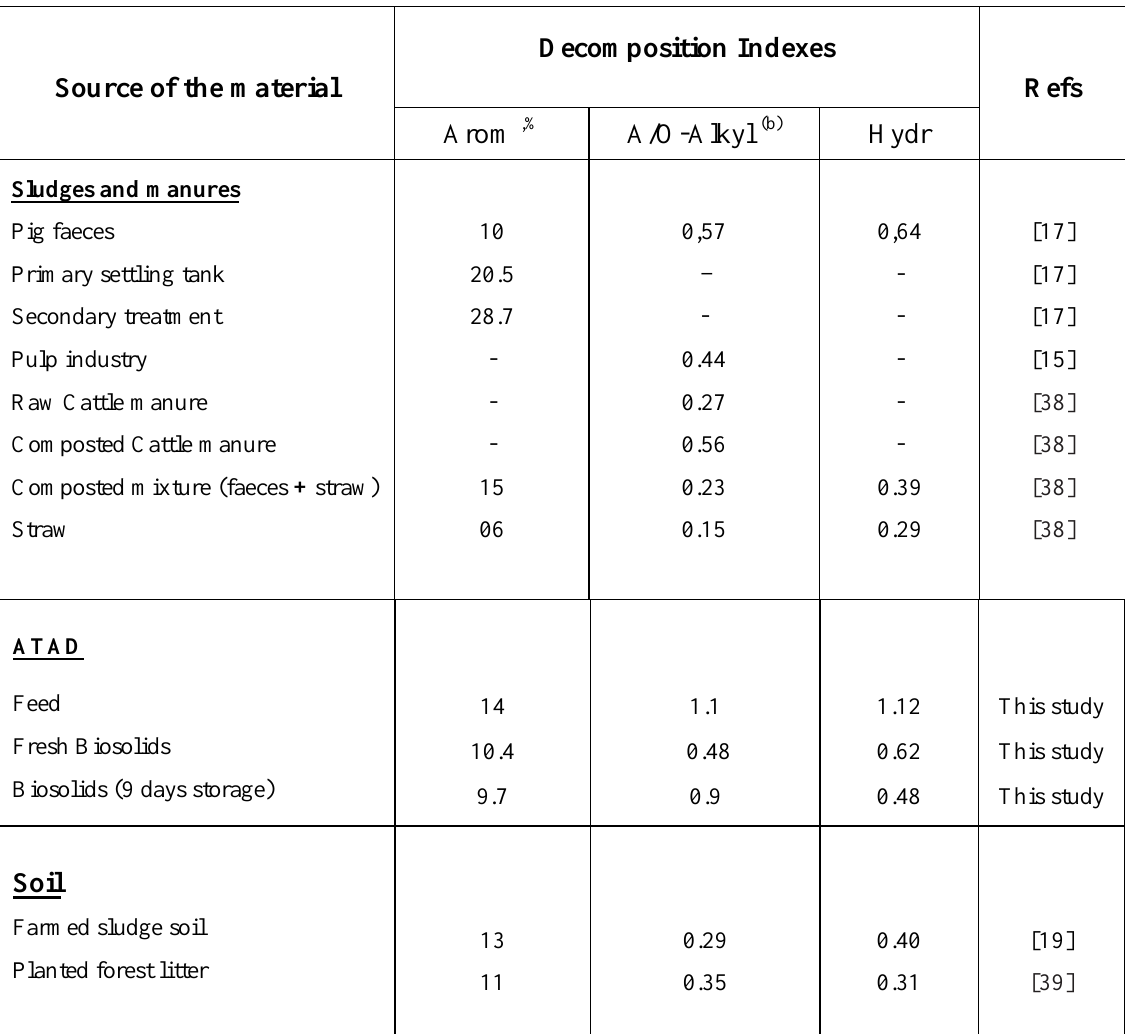
Table 6. Comparison of aromaticity (arom), hydrophobicity (hyd), and alkyl-to-O-alkyl ratios for ATAD from this study and sludges, composts and soils from a variety of the origins reported in the literature. The mean values of the data utilized to perform calculation are presented in Table 2. Aromaticity values were calculated a as described previously